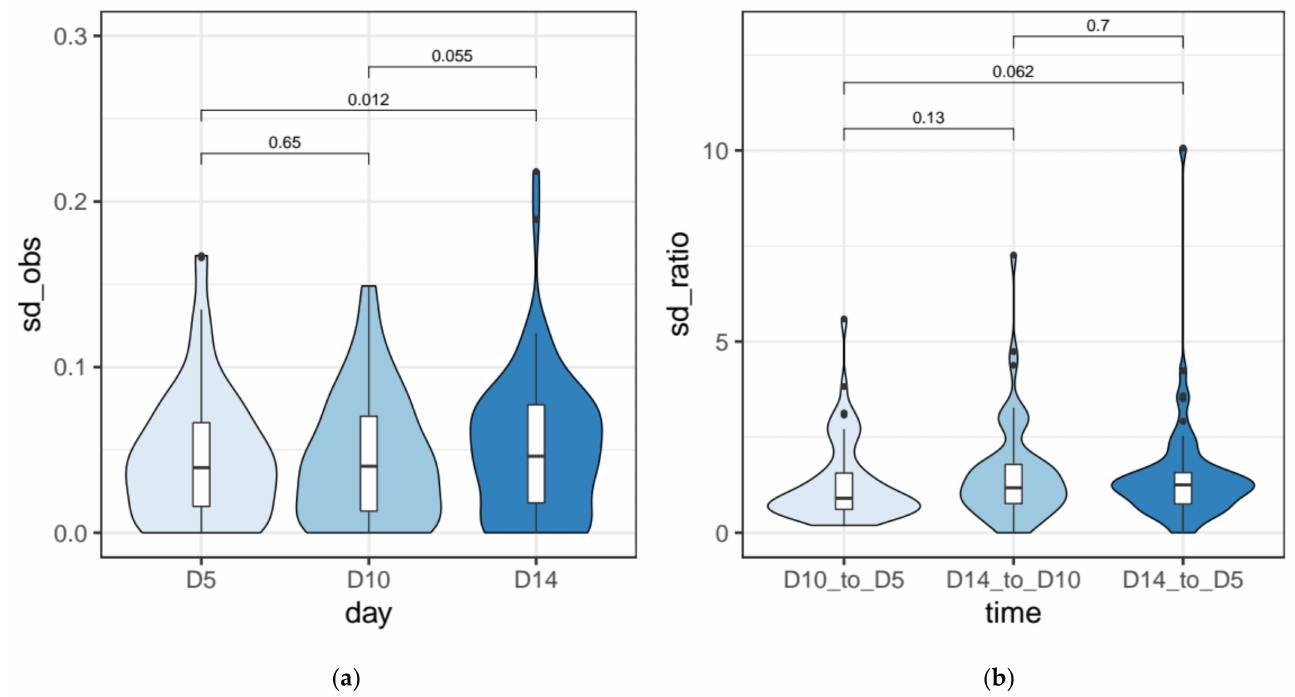
Figure 3. Variability of IES retention scores across time ( a ) Standard deviation of empirical retention levels (observed SD IRS ) 5, 10, and 14 days after self-fertilization (D5, D10, D14) for a highly supported set of IESs ( N = 75). SD IRS values were computed across replicate scDNA samples (D5, n = 4, D10, n = 4, D14, n = 3). ( b ) Standard deviation ratios for empirical retention levels (observed SD IRS ) for a highly supported set of IESs. SD ratios (SDR IRS ) were computed pairwise between time points (D14 to D5, D14 to D10, D10 to D5). N = 60. Distributions were compared with a one-sided Wilcoxon signed-rank test. Pairwise comparisons and raw p values are shown above each